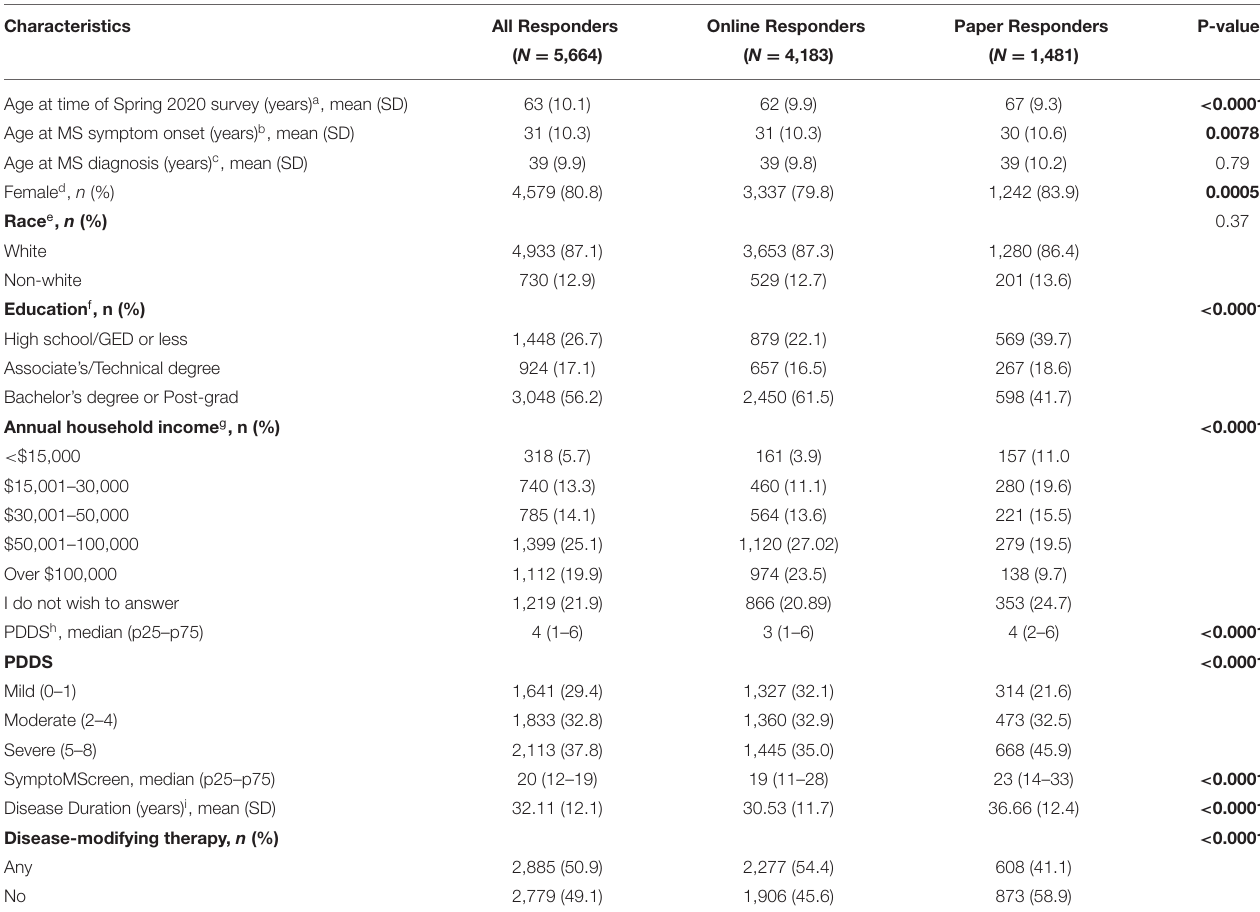
TABLE 1 | Participant